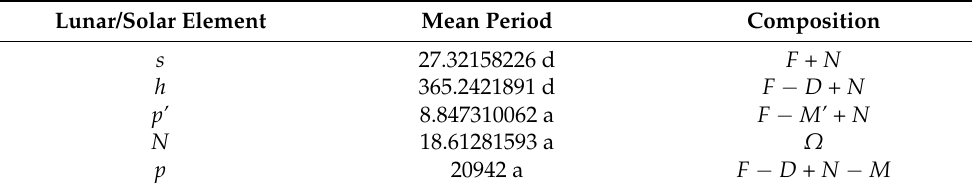
Table 1. Solar and lunar elements with their average period and composition from orbital parameters. Lunar/Solar